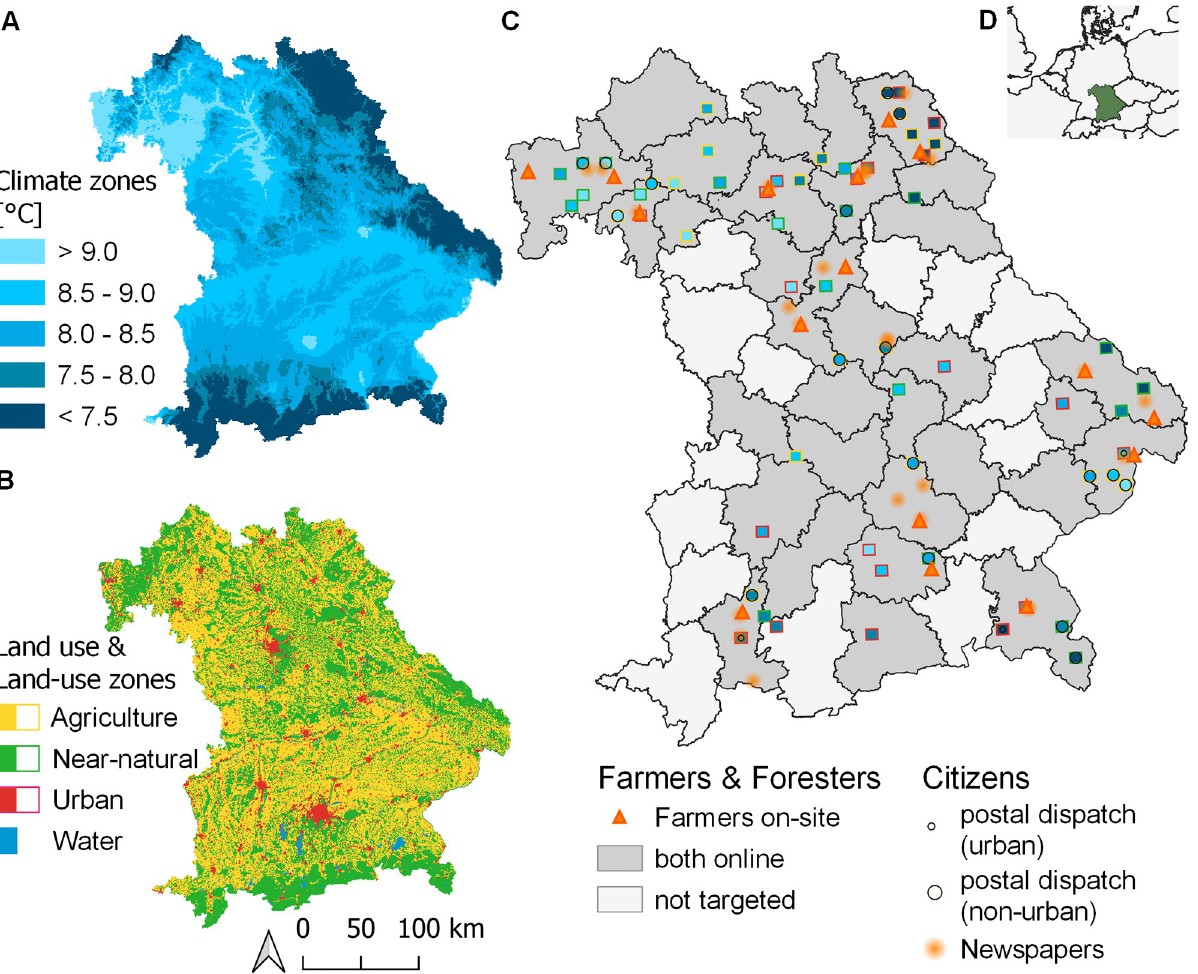
Fig 1. Study region and sampling design: A) Climate zones based on mean annual air temperature (reference period 1981–2010, DWD), B) land-use zones are based on CORINE Land Cover 2012 C) Sampling gradient shown for the 60 focal quadrants with filled colour from A) and border colour from B). Locations of surveys are shown for farmers (orange triangles: on-site locations of Offices of Food, Agriculture and Forestry; grey regions: online distribution via Offices and Agricultural Associations), foresters (online distribution via Offices and Forestry Associations to private and corporate foresters; 20 state foresters per climate zone were addressed via the Bavarian State Forestry BaySF, not depicted), citizens (black circles, urban quadrants with r = 1.5 km, non-urban quadrants r = 3 km to account for different population densities; orange hatches: location of editorial offices of newspapers that invited readers to participate in the survey via articles, r = 10 km is not true to scale of the newspapers’ range of influence); nature managers were contacted independent of their location within the study region and are thus not shown in C. D) Location of the study region Bavaria (green), in Germany and Central